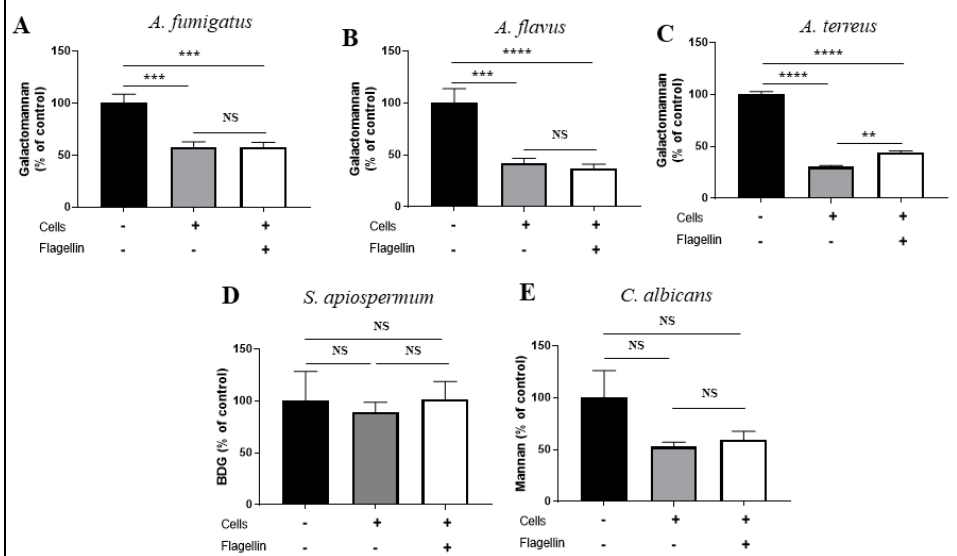
Figure 4. Fungal growth measurement after 15 h of infection under 3 conditions: without BEC representing growth control (100%) (black bars), with BEC (gray bars) and with P. aeruginosa flagellin pre-stimulated BEC (white bars). Fungal growth was quantified in the culture supernatant by using a galactomannan assay for Aspergillus species: 4 strains of A. fumigatus ( A ), 4 strains of A. flavus ( B ) and 2 strains of A. terreus ( C ); ß-D-glucan assay for the 2 clinical strains of S. apiospermum ( D ) and a mannan assay for the 3 clinical strains of C. albicans ( E ). Each bar represents the mean ± SEM of 3 independent experiments, BDG: β -D-glucan; NS: nonsignificant; ** p < 0.01; *** p < 0.001; **** p < 0.0001 (ANOVA Bonferroni).